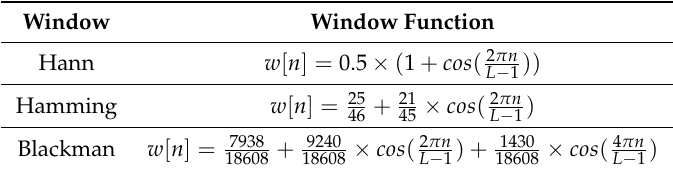
Table 1. Window function of the filters.